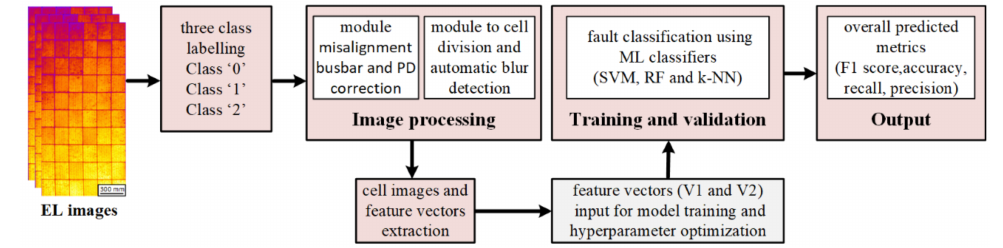
Figure 3. The training procedure used in this